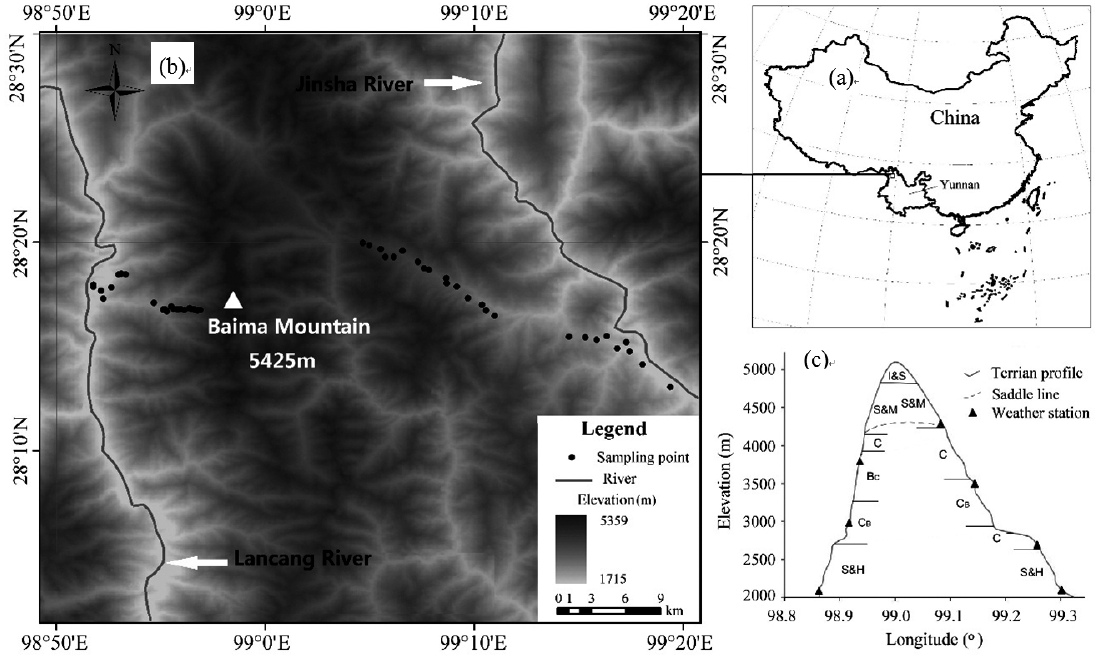
Figure 1. The study area ( a ); distribution of field-sampling sites ( b ); weather stations and the vertical vegetation zones on eastern and western slopes of Baima Snow Mountain ( c ). S&H: shrubs and herbs zone; C: coniferous forest zone; C B : mixed coniferous and broad-leaved forest zone dominated by conifers; B C : mixed broad-leaved-coniferous forest zone dominated by broad-leaved species (mostly evergreen Quercus ); S&M: alpine shrubs and grasses (meadows) zone; I&S: ice and snow zone. Table 1. Meteorological data from seven stations on Baima Snow Mountain: 1987–1988. Parameter Western Aspect Saddle Eastern Aspect Station No.1 No.2 No.3 Elevation, m 2080 2747 3485 Mean annual temperature, °C Annual precipitation, mm